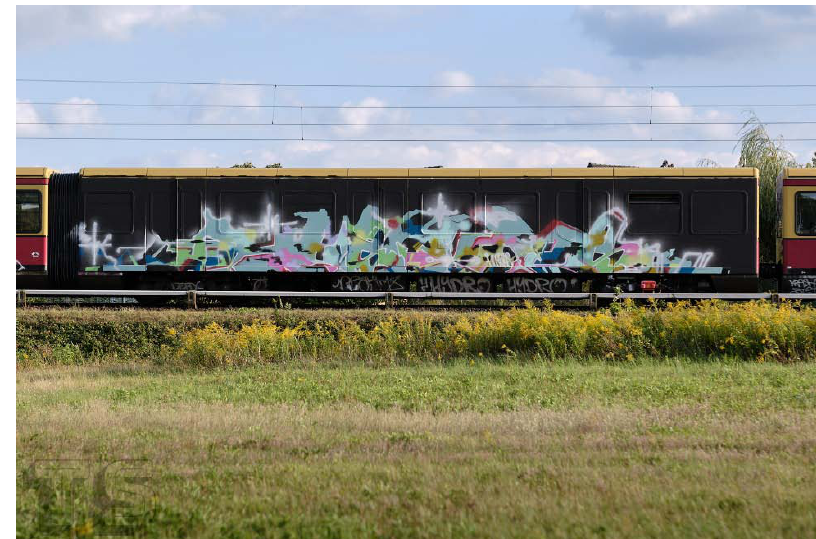
Figure 25. Huskies, Berlin